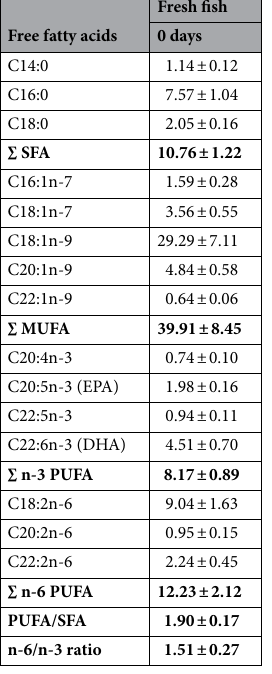
Table 1. Fatty acids (FA) profile (wt.%, g FA/100 g of total lipids) of fresh Atlantic salmon (for values along storage see Table 1S). SFA: total saturated fatty acid; MUFA: monounsaturated fatty acid; PUFA: polyunsaturated fatty acid; EPA: Eicosapentaenoic acid; DHA: Docosahexaenoic